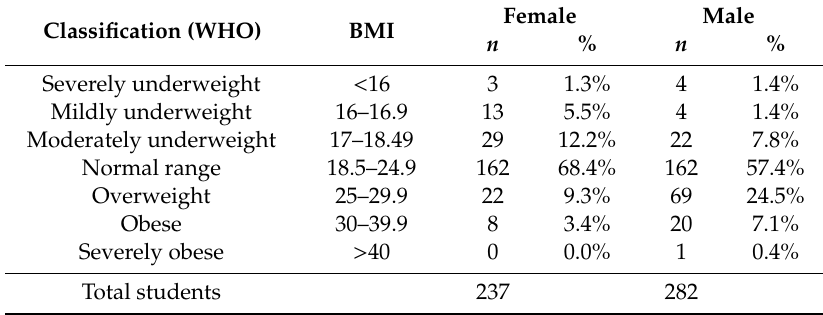
Table 2. Total number and percentage of students, stratified according to body mass index (BMI). Classification (WHO)